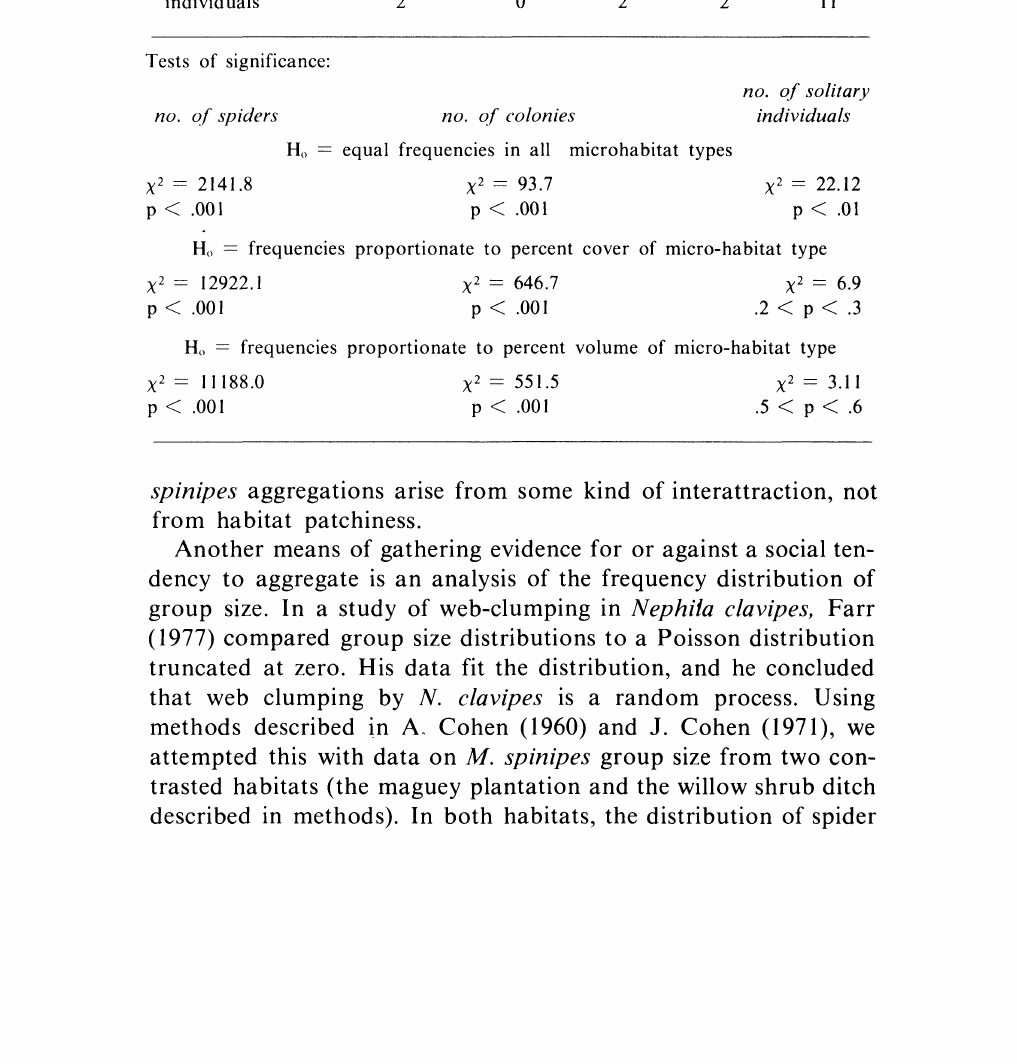
Table 1. Distribution of Metepeira spinipes in several microhabitat types. Microhabitat Agave Opuntia Trees